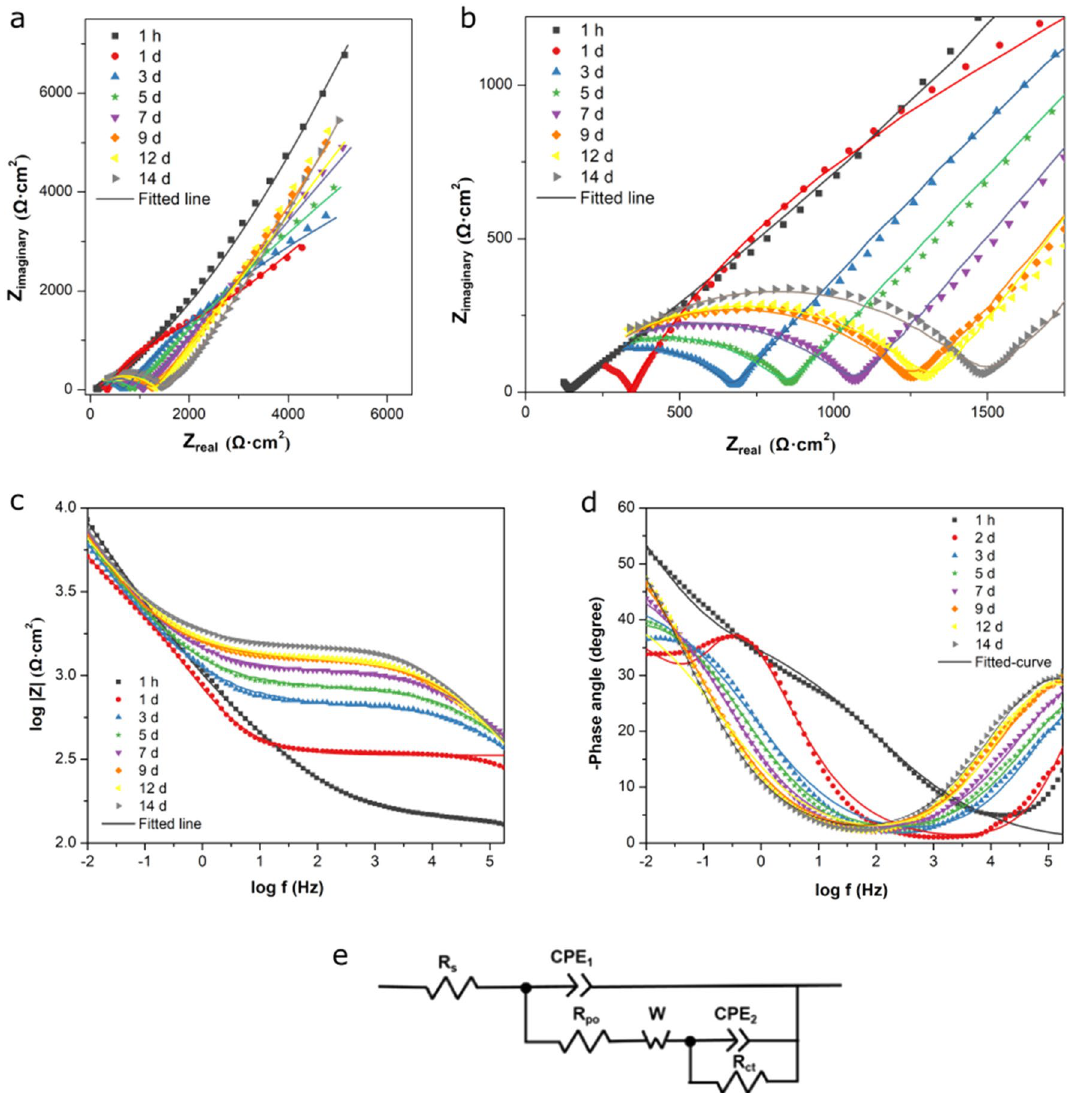
Figure 6. ( a – d ) Electrochemical impedance spectra of MPC-coated mild steel immersed in 3.5% NaCl ( a , b : Nyquist plots; c , d : Bode plots); ( e ) equivalent circuit used to model the